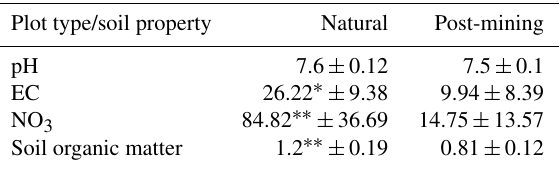
Figure 2. Incubation setup. Top picture – biocrusts in sealed glass vials in the incubator. Bottom picture – natural (a) and post- mining (b) biocrusts following the 96h incubation. Table 1. Soil properties for natural and post-mining biocrusts. The numbers represent the means for each property and the stan- dard deviation. Significant differences are marked with an asterisk ( ∗ p< 0 . 05; ∗∗ p< 0 . 01).